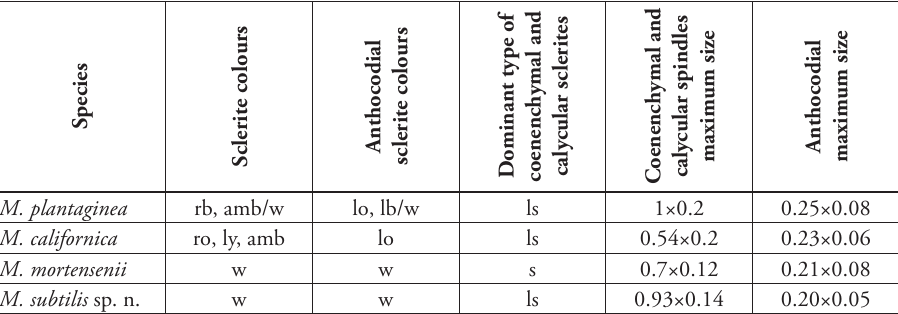
Table 1. Diagnostic characters of sclerites in the Muricea plantaginea species-group. Measurements given are from the holotypes and lectotypes, in mm.